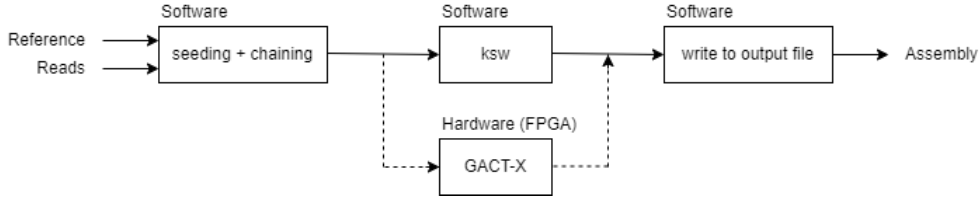
Figure 2. Diagram of Minimap2’s pipeline with GACT-X replacing the ksw function for alignment. Minimap2 computes the seeding and chaining steps from a reference sequence and reads inputs. The ksw function, performing the SK algorithm, and GACT-X receive as inputs the read sequences and their mapping positions in the reference, and deliver as outputs the SWG alignments. The alignments are organized and written to an output file that corresponds to the assembly of that set of